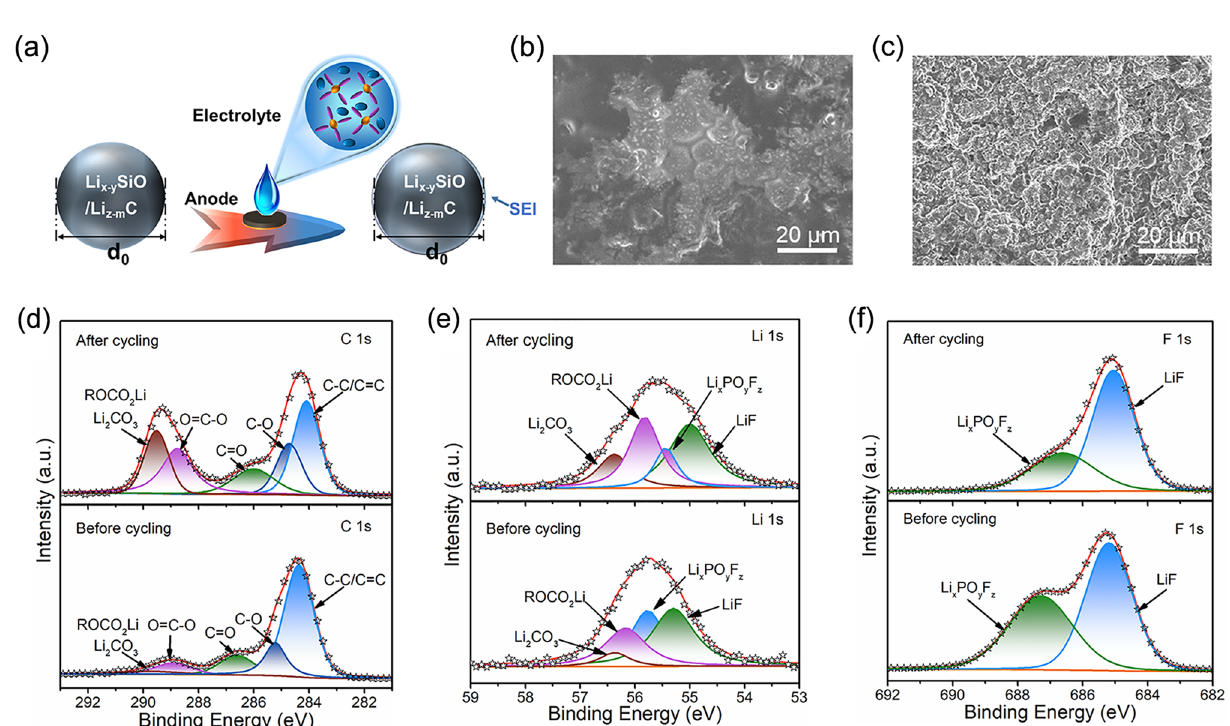
Fig. 6 a SEI film constructed by contacting the prelithiated electrode with the electrolyte. SEM images of p-SiO/C anodes b before cycling and c after cycling. Refined XPS high-resolution spectra of d C 1 s , e Li 1 s and f F 1 s of p-SiO/C anodes before and after